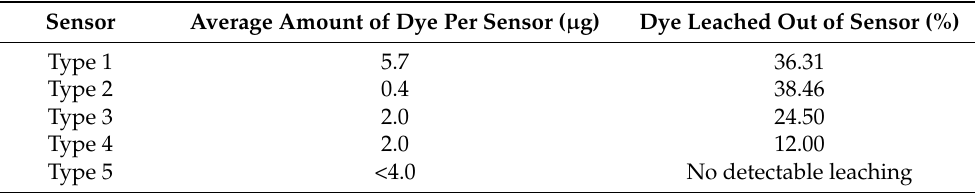
Table 2. Leaching of PtBP dye from the different sensors in 95% ethanol.